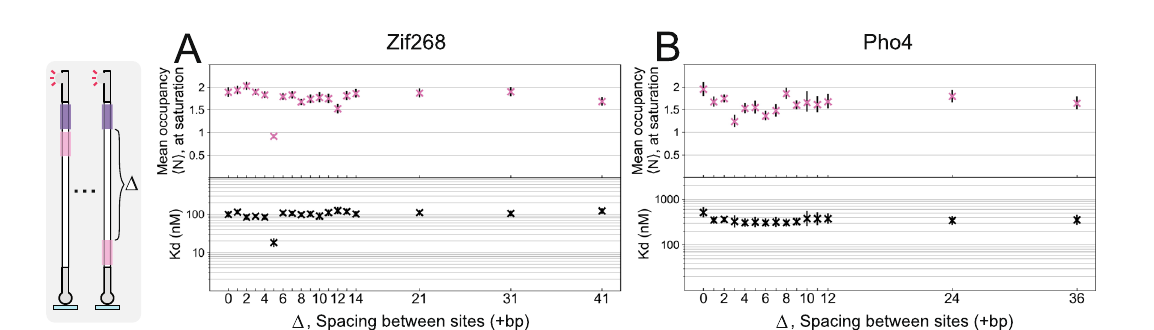
h N i max parametermarkersarecenteredatthemean,whileerrorbarsrepresent5to 95% con fi dence intervals. Samples were analyzed in 18 – 34 independent chambers, across 2 independent